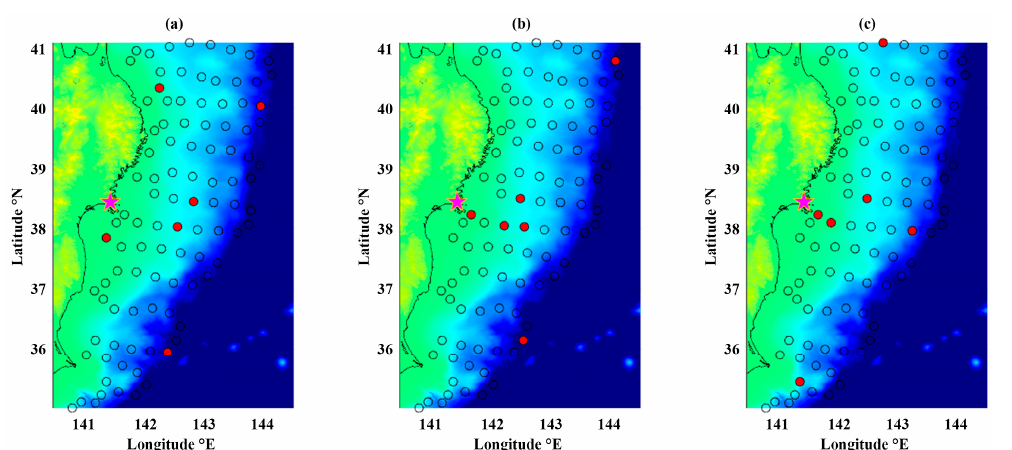
Figure 16. Spatial maps of sensors for the risk-based early warning in Onagawa: ( a ) 5 min, ( b ) 10 min, and ( c ) 20 min. The pink star represents the target location (Onagawa). The red and empty circles represent the selected and unselected sensors, respectively.